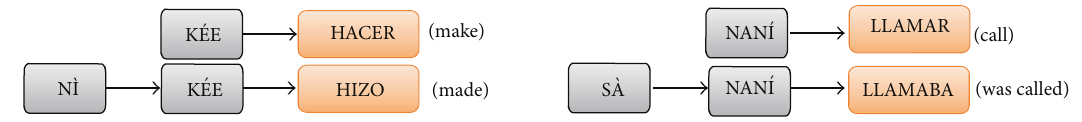
Figure 11: Example of verb tenses in the Mixtec-to-Spanish translation model (TM 𝑋𝑃 ).